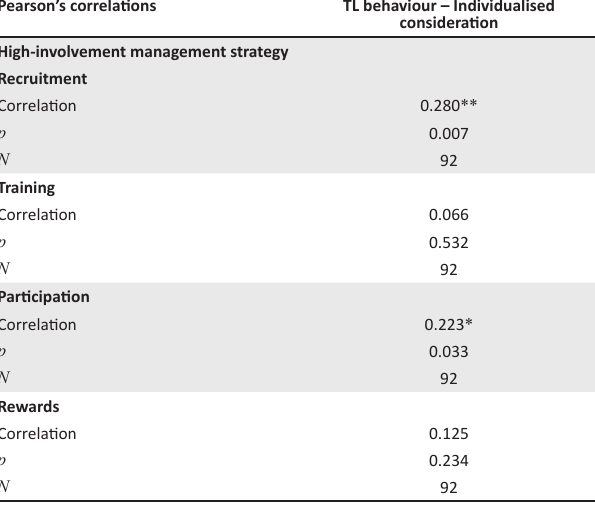
TABLE 6: Correlations of transformational leadership behaviour – Individualised consideration and high-involvement management strategy. Pearson’s correlations